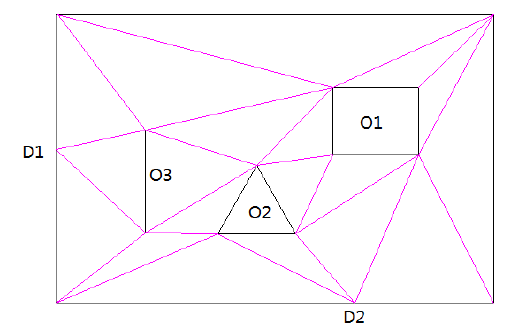
Figure 3. Regional subdivision